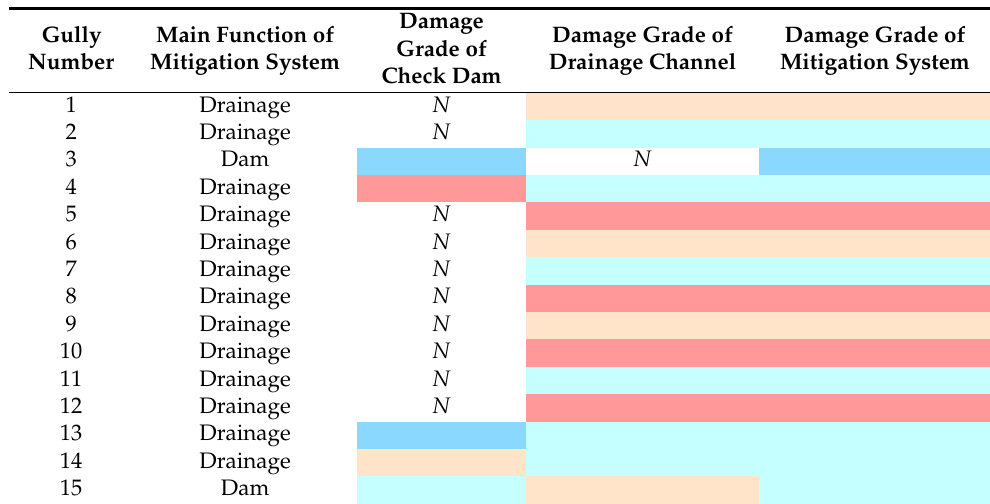
Table 5. Damage evaluation of the mitigation systems of single debris flow gullies. (The legend of damage grade is the same as Figure